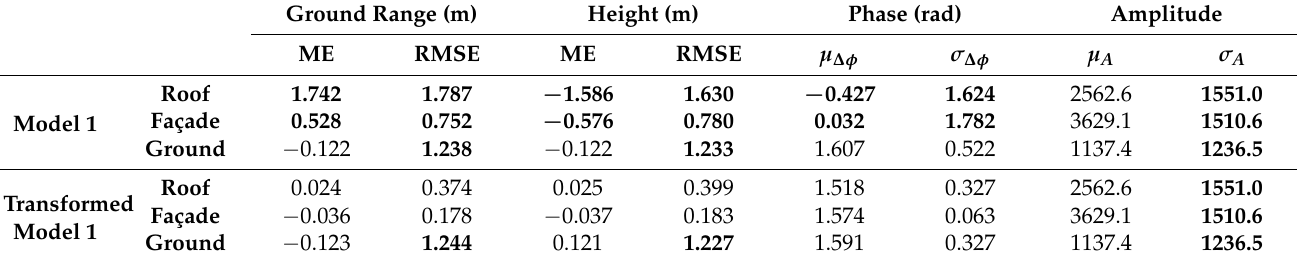
Figure 19. The reconstruction obtained under model 1 (the exact form of the planar wavefront model) after transformation in experiment 2: ( a ) reconstruction with colors denoted as height, ( b ) reconstruction with colors denoted as amplitude, ( c ) reconstruction with colors denoted as phase, ( d ) the off-nadir angle of the reconstruction, ( e ) the error of the ground range and height, ( f ) the error of the phase. Table 4. The quantitative analysis of inversion results using simulated data in experiment 2.